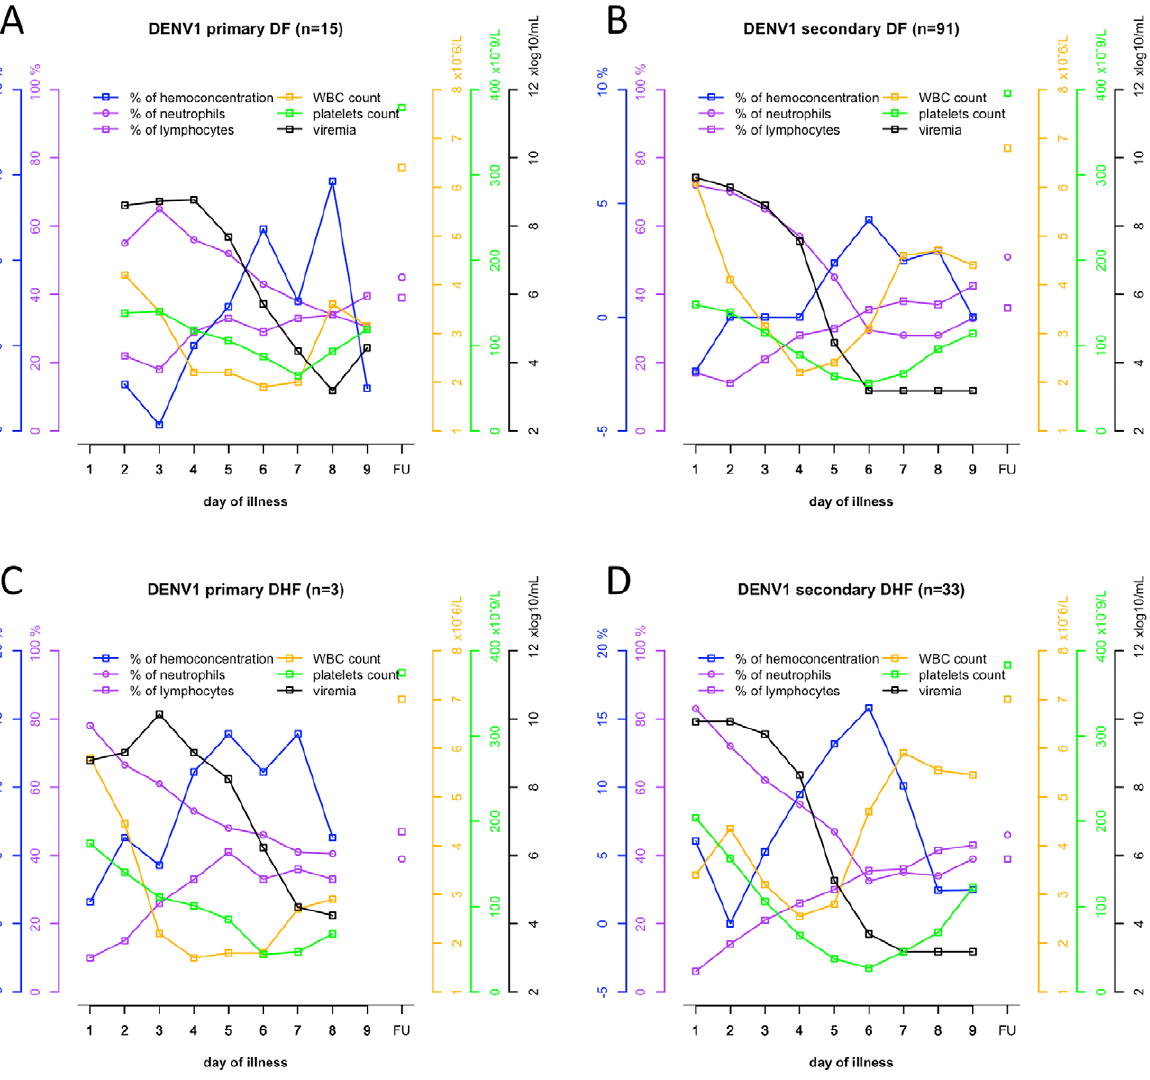
Figure 6. Profile of haematological parameters and viremia in DENV-1 infected patients. Medians of viremia levels, WBC and platelet counts, hemoconcentration, and percentages of lymphocytes and neutrophils were determined in serial plasma samples from DENV-1 infected patients with A ) primary DF, B ) secondary DF, C ) primary DHF and D ) secondary DHF. The numbers below the graph indicate the numbers of patients at each time point. For reasons of clarity, error bars are not